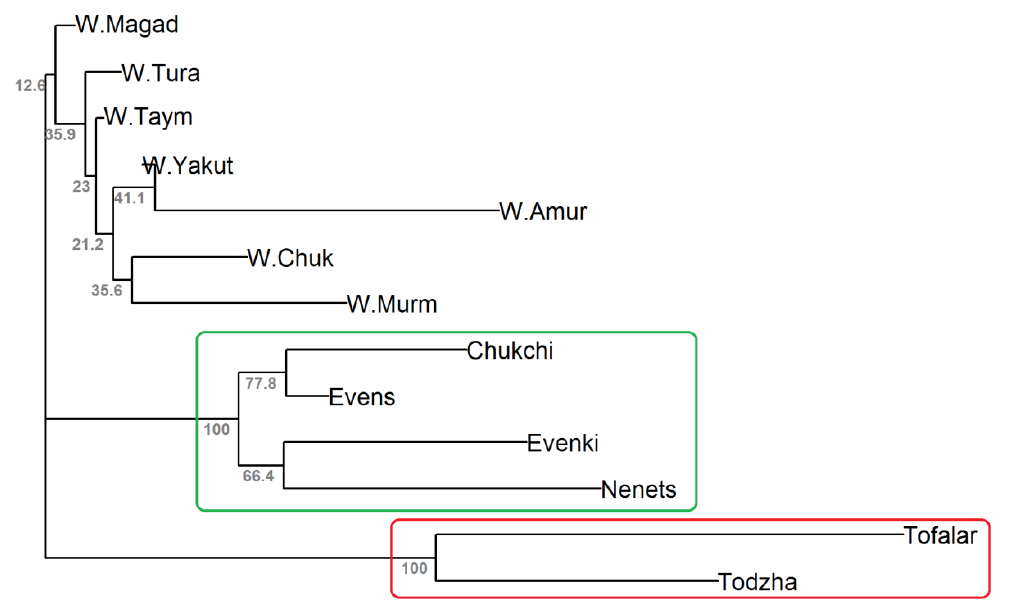
Figure 4. Phylogenetic tree constructed by the neighbour-joining algorithm. Numbers at the branch nodes indicate the confidence values for each branch obtained using the bootstrap procedure. The red and green rectangles show clusters with BS >